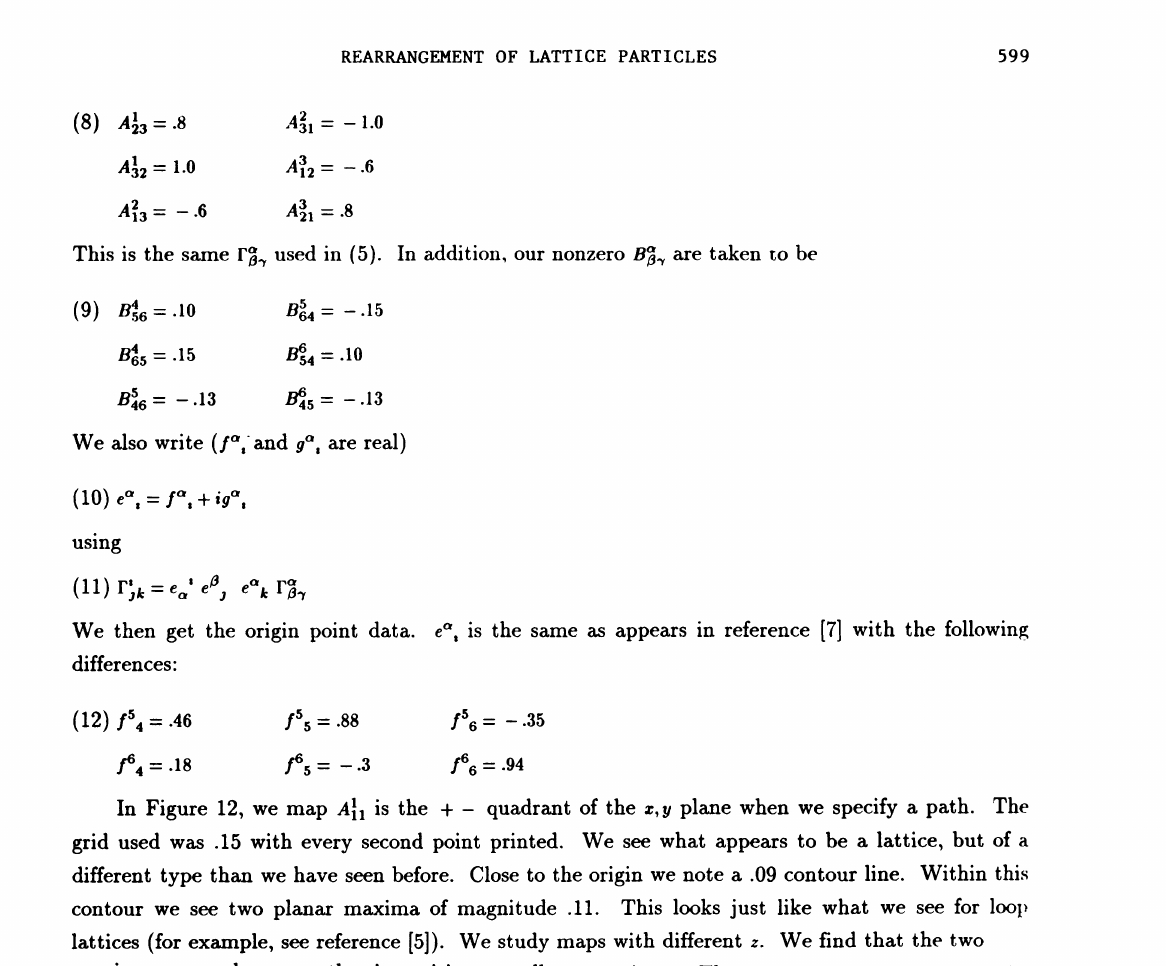
Table III. Magnitude of Planar Maxima (Minima) at v 3 4-1 as